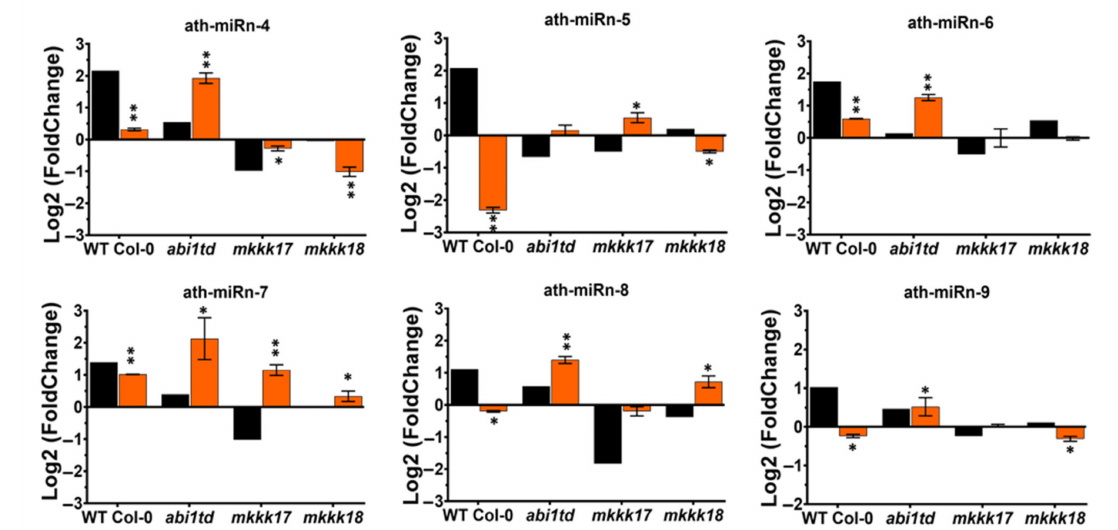
Figure 8. Validation and comparison of RNA sequencing results by real-time PCR. Comparisons between real-time validation and gene expression profiling data of randomly selected known and novel miRNAs in Arabidopsis WT Col-0, abi1td , mkkk17 , and mkkk18 mutants before or after four hours of 100 µ M ABA treatment (mock- and ABA-treated). The x -axis represents genotype names, while the y -axis represents the relative expression level of miRNAs. The expression levels of miRNAs are normalized to the level of SnoR66 . Black bars represent the expression from log2 (fold change) of the NGS data, while orange bars represent the qPCR log2 (fold change) values. Data from qRT-PCR are means of three biological replicates with each having three technical replicates. Error bars represent ± SD (standard deviation) from triplicates. Student’s t -test was performed on mock-treated and four hours of 100 µ M ABA-treated results of qRT-PCR, and the statistically significant treatments are marked with * ( p -value ≤ 0.05), ** ( p -value ≤ 0.001).